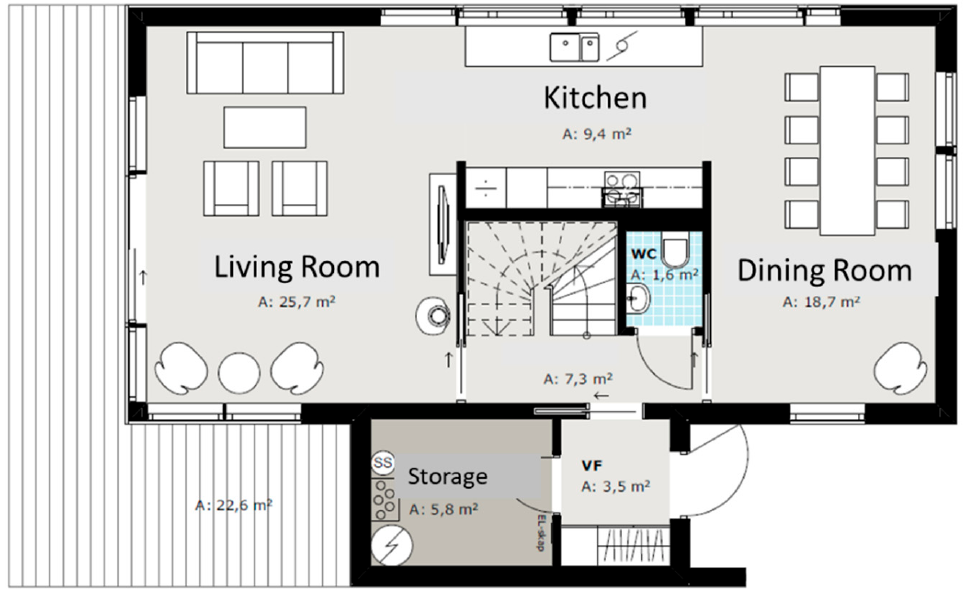
Figure 4. Layout of the first floor (Source: Norgeshus).